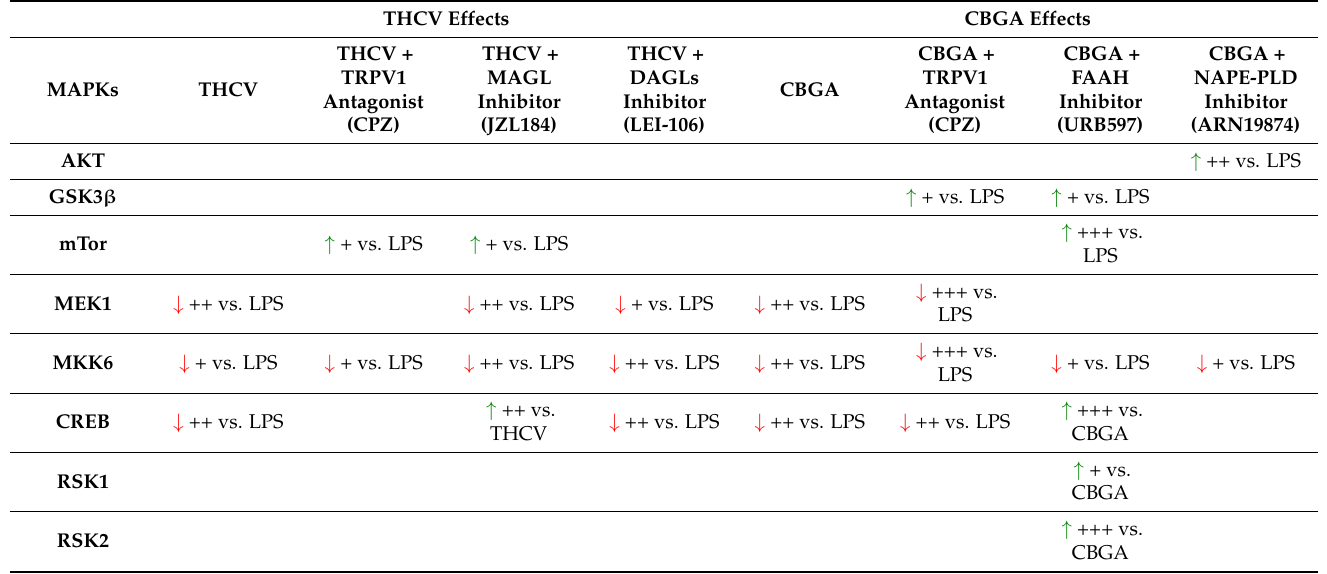
Table 2. Summary of the most significant effects of MAPK protein expression in response to eCB system elements in presence of antagonists and inhibitors after HaCaT cells were treated for 24 h with LPS and with THCV and CBGA. Legend: ↑ significant increase; ↓ significant decrease; + p < 0.05; ++ p < 0.01; +++ p < 0.001 vs. LPS, THCV and